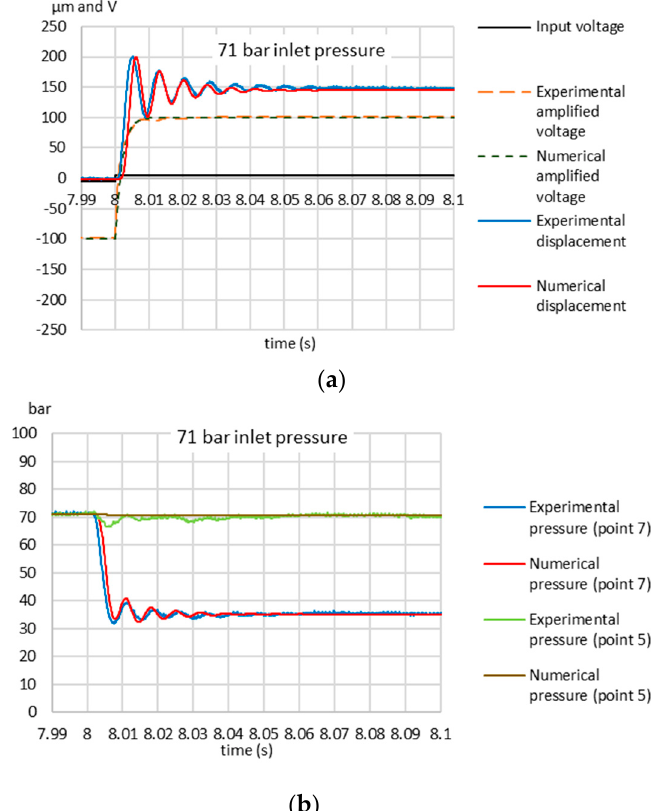
Figure 6. Test 2 (71 bar supply pressure). Comparison between measured amplified voltage and simulated one and between measured displacement and simulated one for a positive step control voltage (input voltage to the amplifier) from − 5 V to + 5 V: ( a ); comparison between measured pressures and simulated ones: ( b ).